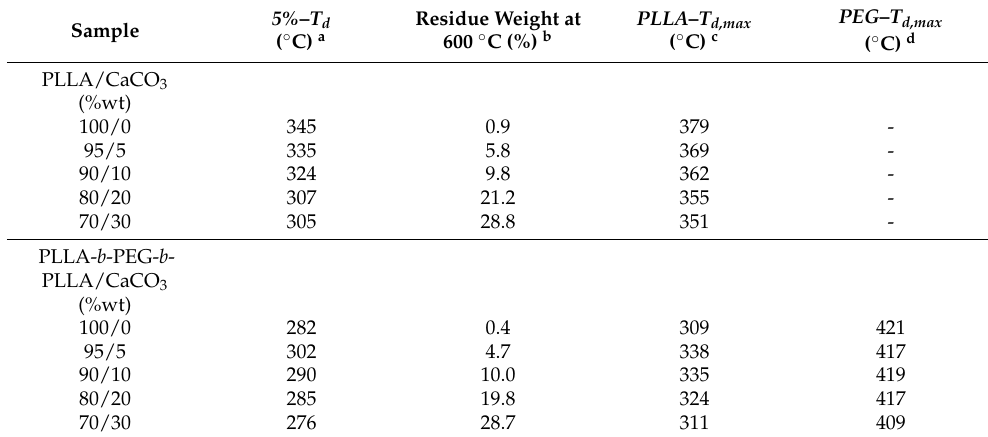
Table 3. Thermal decomposition properties of the composites.